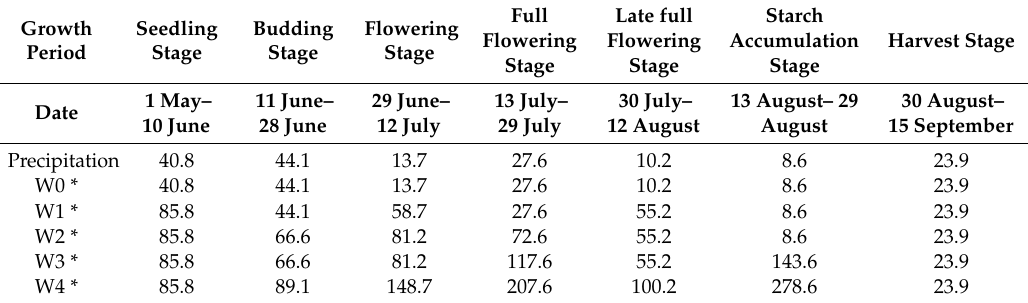
Table 1. Irrigation and precipitation (mm) during the growth period in